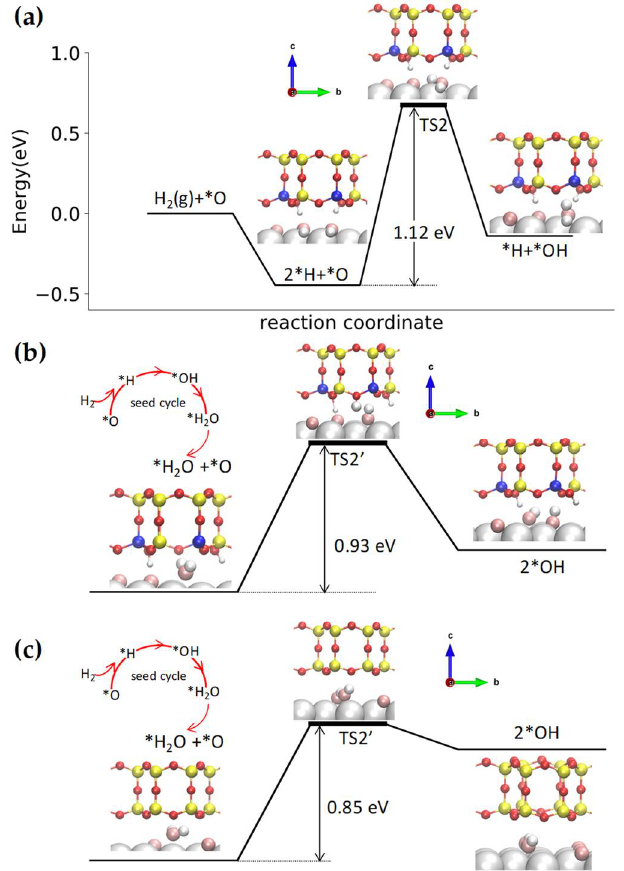
Figure 6. Potential energy diagram for the WFR at the BL-aluminosilicate/Ru(0001) interface via ( a ) first hydrogen addition step (*H + *O ⟷ *OH) and ( b ) disproportionation pathway (*H 2 O + *O ⟷ 2 *OH); ( c ) Potential energy diagram for the disproportionation pathway (*H 2 O + *O ⟷ 2 *OH) at the silica/Ru(0001) interface. Color code: Ru (silver), Si (yellow), Al (blue), H adsorbed on aluminosilicate (small white), O in aluminosilicate (red), *O chemisorbed on Ru (pink), and *H adsorbed at the aluminosilicate/Ru(0001) interface that react with *O (large white).